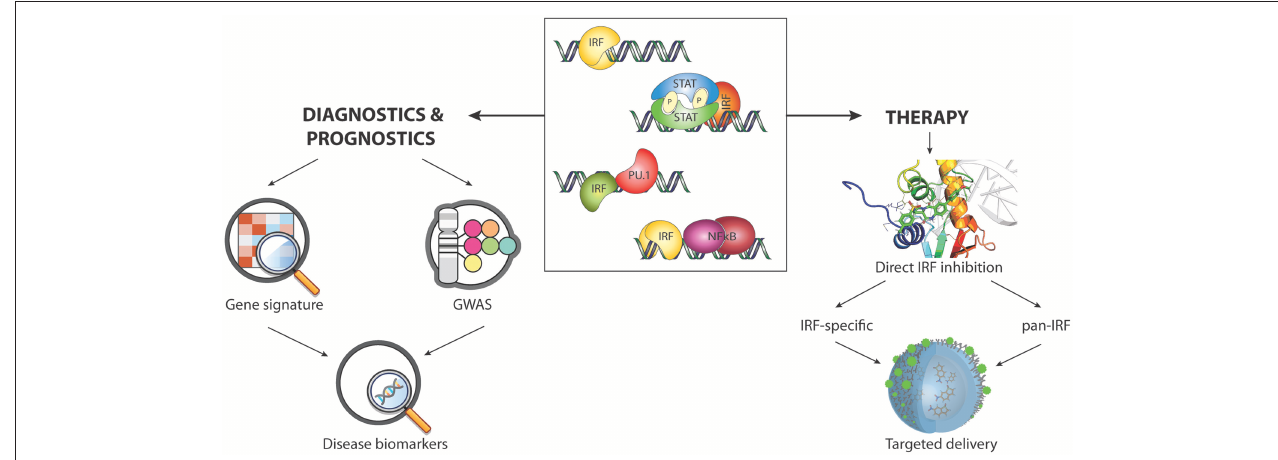
FIGURE 5 | Therapeutic, diagnostic, and prognostic space occupied by IRFs and IRF-mediated transcription regulatory mechanisms. IRF-containing complexes involved in transcriptional regulation, including IRF homodimers, STAT/IRF, PU.1/IRF, and NF- κ B/IRF (central), can serve as diagnostic and therapeutic targets in different ways. The analysis of IRFs transcriptional mechanisms together with GWAS and characterization of gene expression signatures might provide disease diagnostic and prognostic markers (left side). Novel IRF-specific and pan-IRF inhibitors combined with an appropriate delivery system have the potential to be effective therapeutic agents for numerous immune related diseases (right side). We propose nanoparticles as promising tool for IRF inhibitory compound